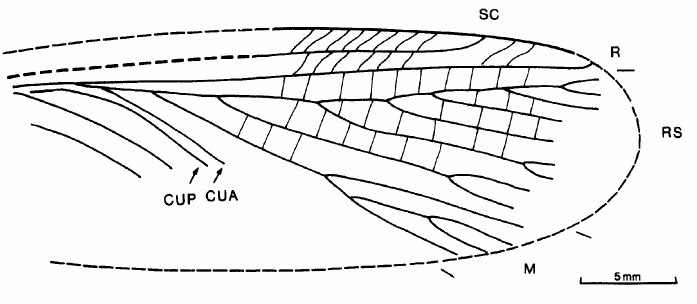
Fig. 7. Gerarus danielsi, originally Genopter.vx constricta. Drawing of hind wing, based on USNM 38148. Compare this with the hind wing in Fig.